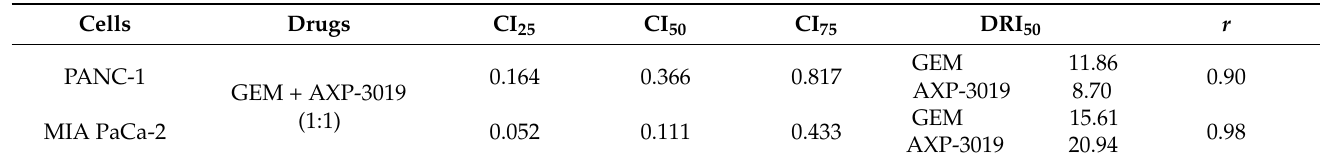
Table 2. Combination index (CI) and dose-reduction index (DRI) values of GEM + AXP-3019combination on PDAC cell lines after 48h of treatment.